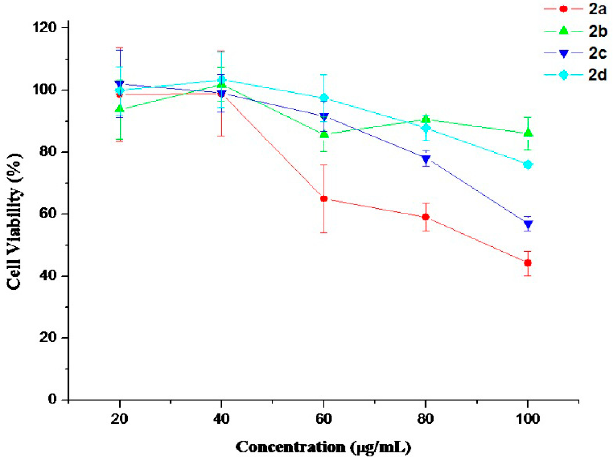
Figure 14. Relative cell viabilities of compounds 2a – d in HL-7702 cells.